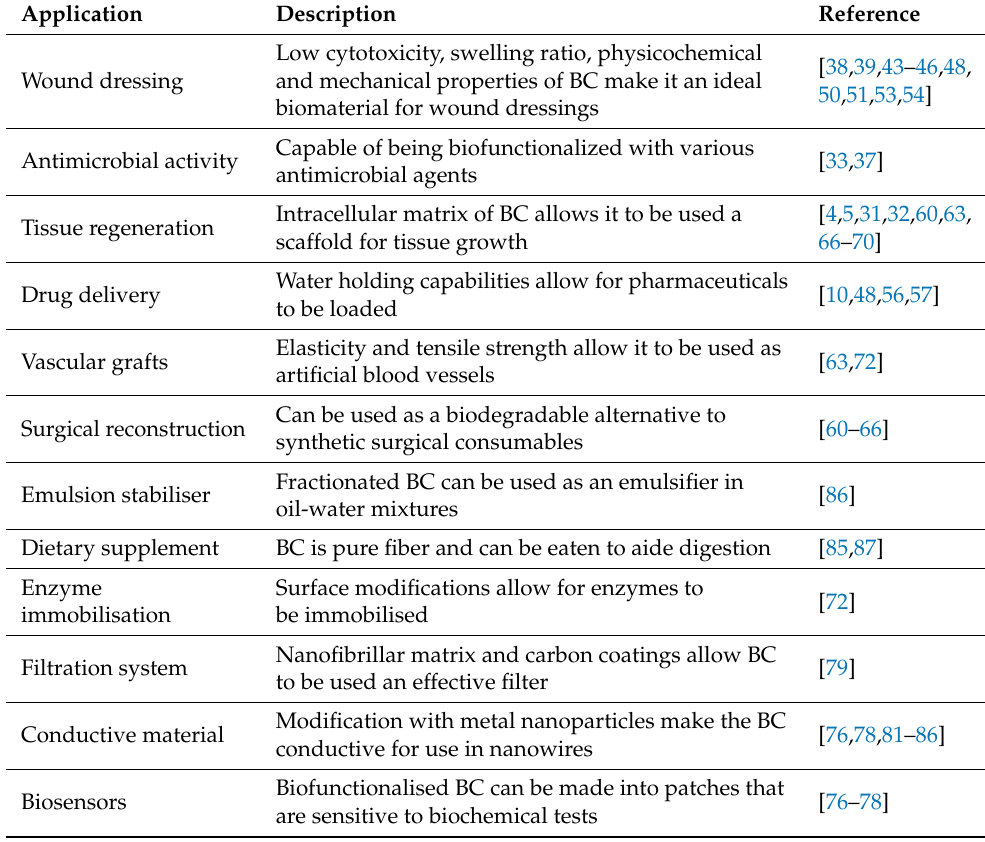
Table 2. Summary of various applications in which bacterial cellulose has been used.